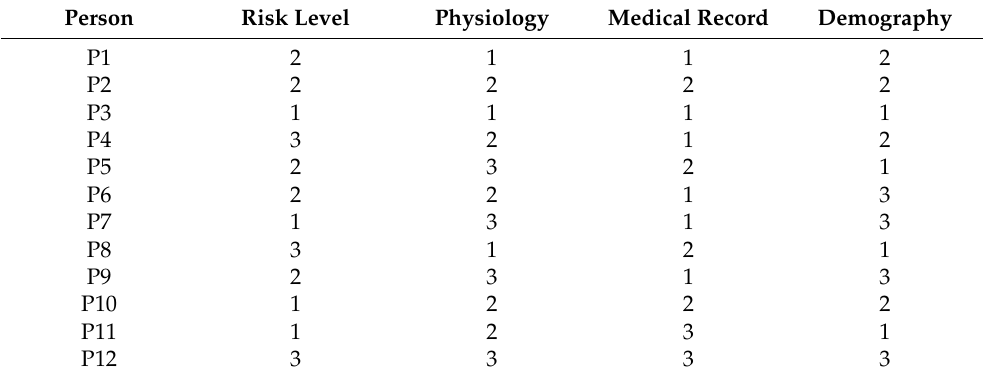
Table 2. Dataset of Participant